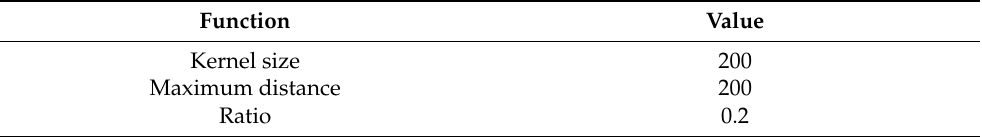
Table 2. Superpixel calculation